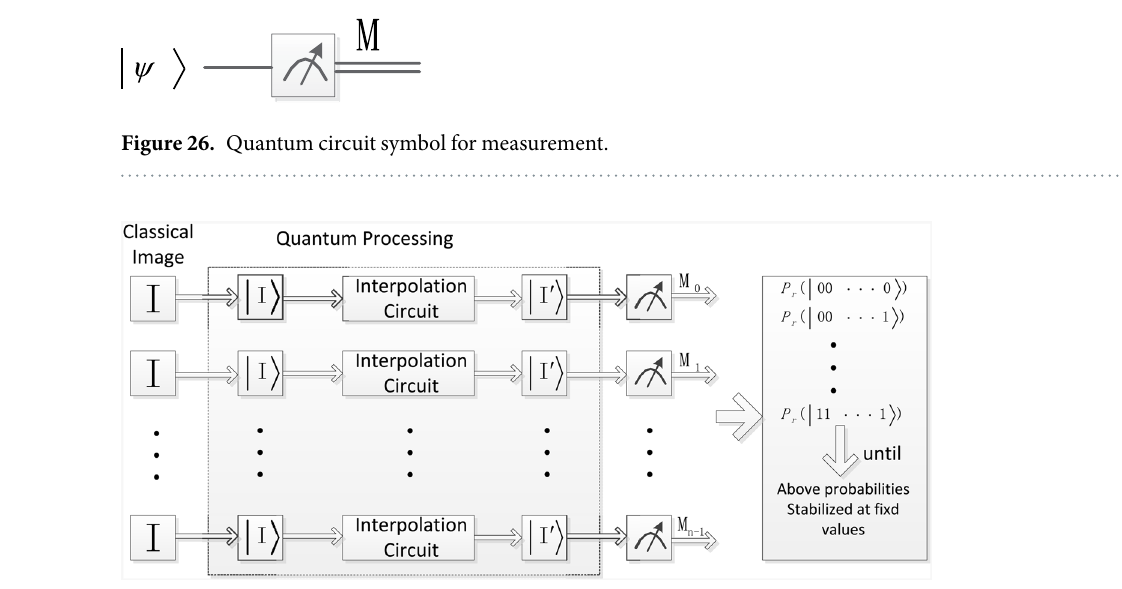
Figure 27. The block diagram of the measurement procedure on quantum